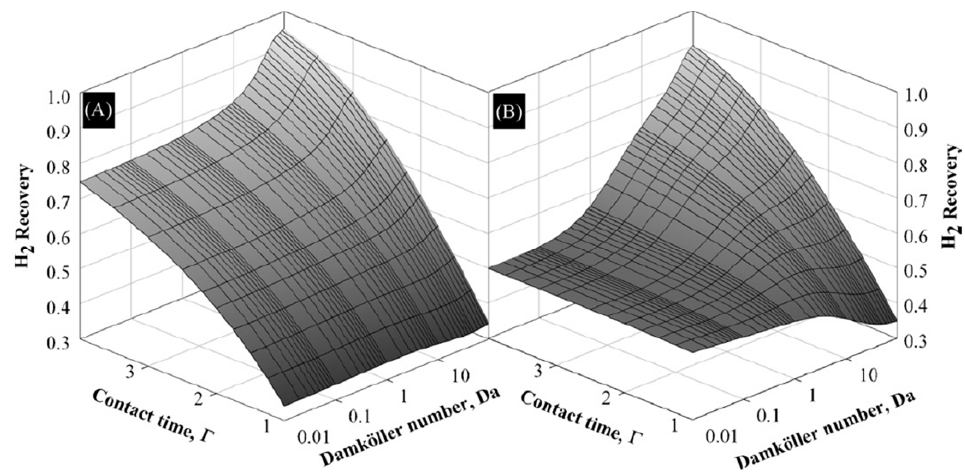
Figure 9. Simulation results of MSR reaction: Hydrogen recovery vs. contact time and Damköhler number: ( A ) carbon molecular sieve (CMS) MR, ( B ) Pd MR. With permission of reprint of Elsevier from Sà et al. [48].